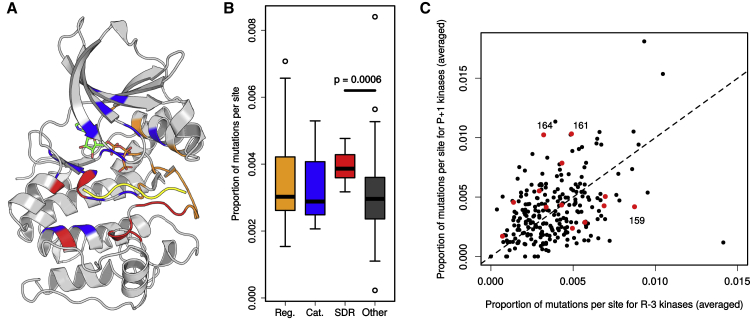
Mutation of SDRs in Cancer(A) Kinase domain positions are colored according to their functional category (regulatory: orange, catalytic: blue, SDR: red, “other”: gray). The substrate peptide is represented in yellow and ATP in green, orange, and red (PDB: 1ATP).(B) The fractions of mutations mapping to a given site for a given Ser/Thr kinase were calculated and then averaged across all Ser/Thr kinases. The different sites are grouped according to their functional category. Mutations in SDRs are more frequent than in "other" residues (Mann-Whitney, p = 6 × 10−4).(C) For a given site, the frequency of mutations in arginine-3 kinases (x axis) and proline+1 kinases (y axis) is plotted. Predicted SDRs are colored in red.